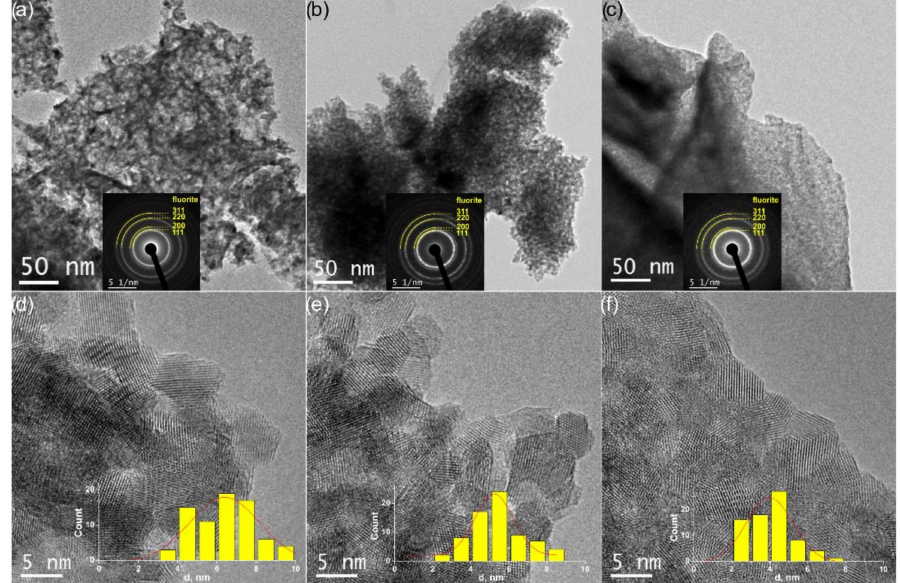
Figure 2. TEM data for Ce 0.9 Zr 0.1 O 2 ( a , d ), Ce 0.75 Zr 0.25 O 2 ( b , e ), and Ce 0.5 Zr 0.5 O 2 ( c , f ) catalysts: ( a – c ) TEM images and SAED patterns in insets with indication of fluorite phase rings; ( d – f ) HRTEM images and particle size distribution